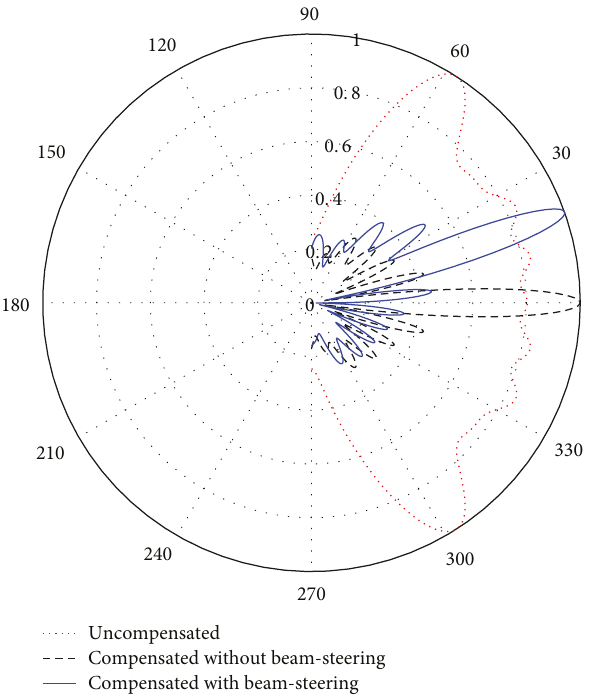
Figure 14: Polar pattern of bent ULA.